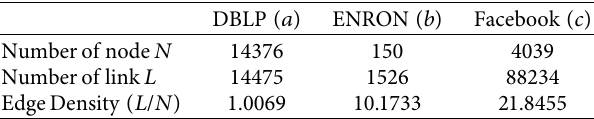
Table 4: Another directed network